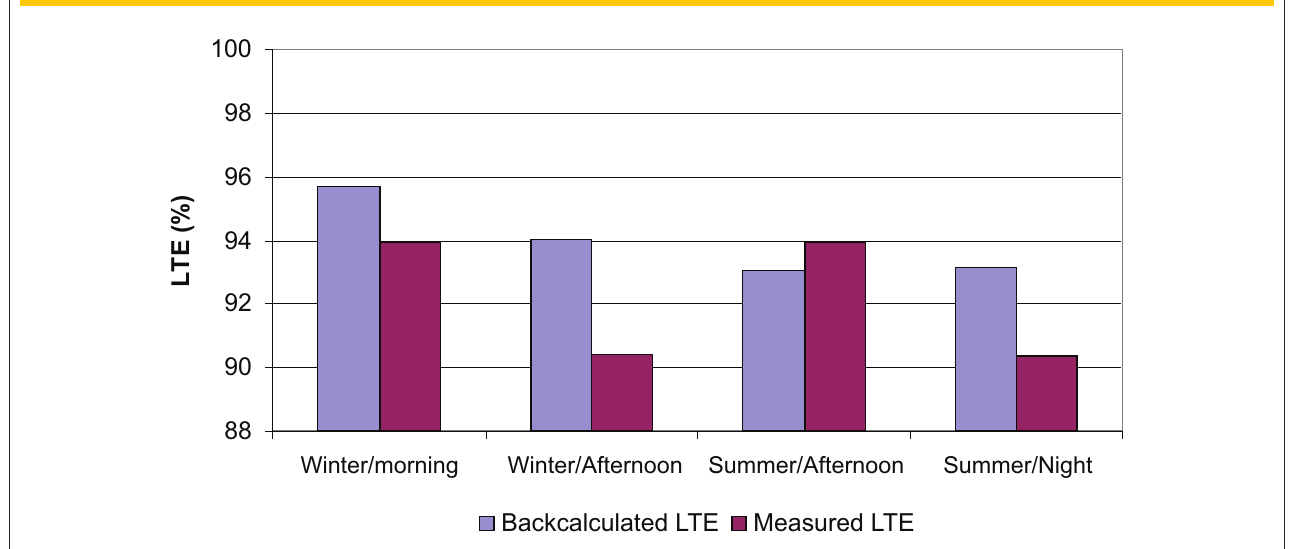
Figure 8 – Comparison of backcalculated and measured LTE values for doweled joints (by